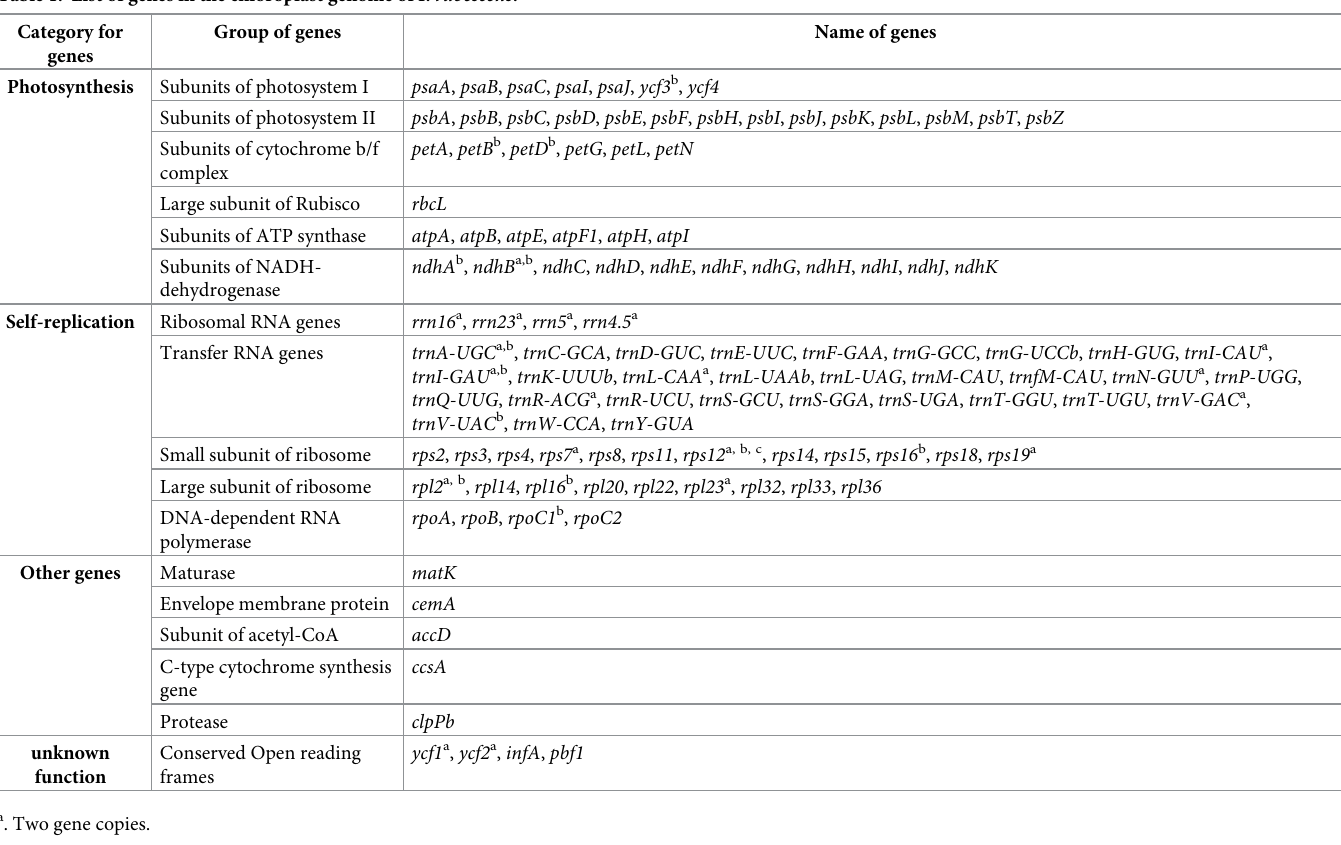
Table 1. List of genes in the chloroplast genome of I . rubescens . Category for